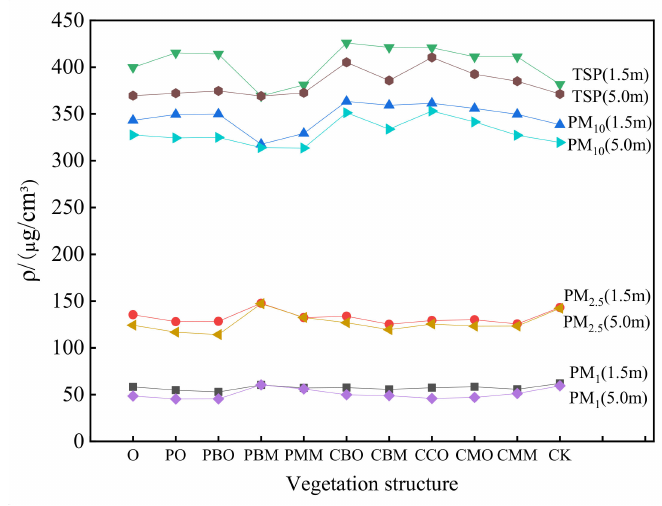
Figure 7. Distribution of mean changes in airborne particulate matter by vertical height. In the sample plots with different vegetation structures, the concentrations of airborne particulate matter with different particle sizes at different heights were different (Figure